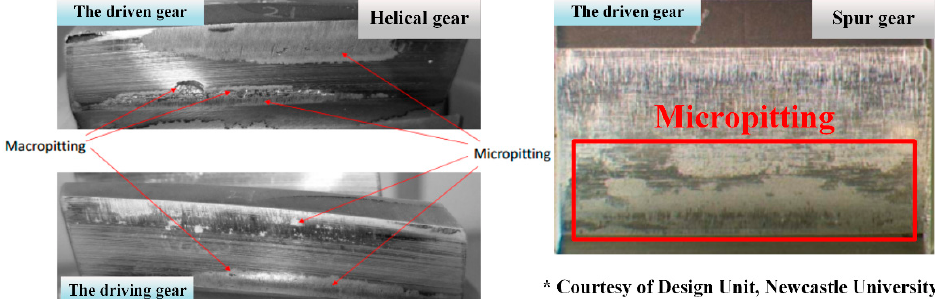
Figure 2. The reproduced micropits observed on the case-hardening and ground gear tooth flank after the experiments.